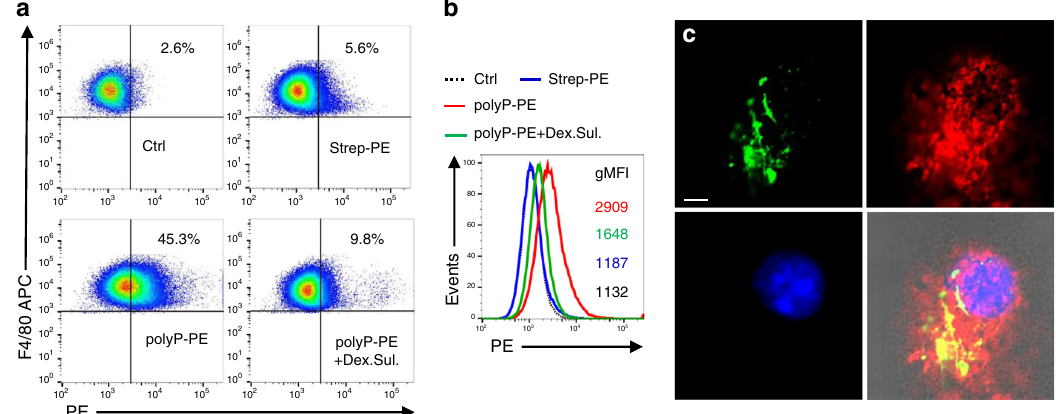
Fig. 2 Macrophages bind and internalize polyphosphates. a CD11b + F4/80 + macrophages (BMDM) from C57BL/6J mice were incubated with biotinylated L-polyphosphates (50 μ M) for 30 min on ice followed by streptavidin-PE (PolyP-PE). The negative controls were unstained (Ctrl) or streptavidin-PE (Strep-PE) only. The preincubation with dextran sulfate (Dex. Sul., 100 μ g/ml) for 15 min reduced the binding of polyphosphates to macrophages; fl ow cytometry with pre-gating on CD11b + cells (CD11b-Paci fi c Blue). b Representative overlay histograms from the same experiments as shown in frame ( a ) and numbers of geometric mean fl uorescence intensities (gMFI). c Live cell imaging of macrophages incubated with biotinylated L- bar: 5 µ m. Data are representative of three ( a , b ) and two ( c ) independent